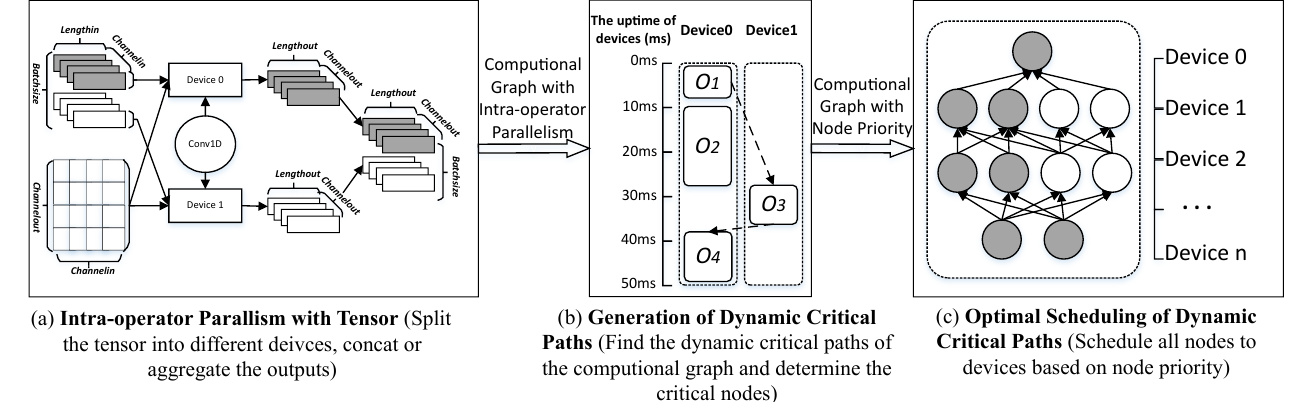
Figure 1. Architecture of FD-DPS